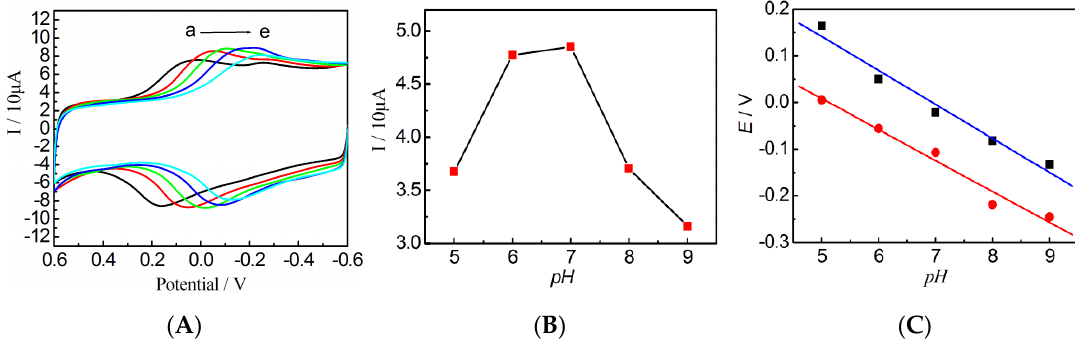
Figure 4. ( A ) CVs of RIF at the MWCNTs-CeO 2 nanorods/GCE in 0.1 M PBS with different pH (a—5.0, b—6.0, c—7.0, d—8.0, e—9.0); ( B ) The relationship between the reduction peak current and pH; ( C ) The relationship between the peak potential and pH (The reduction peak potential (blue) and The oxidation peak potential (red)). Scan rate: 0.10 V/s.